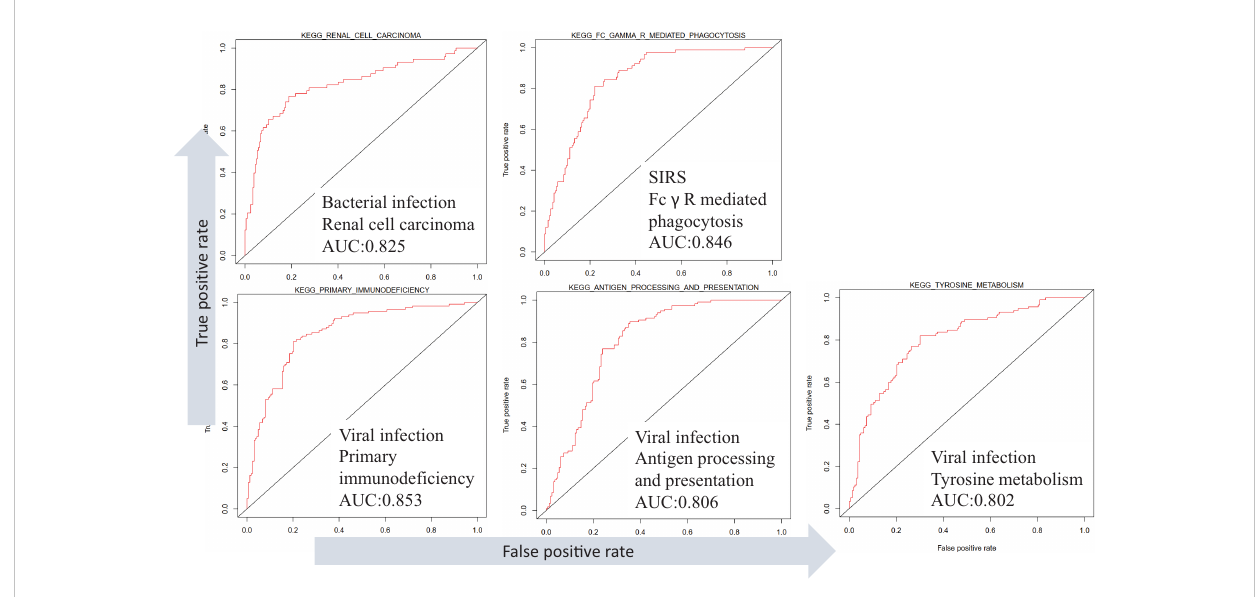
FIGURE 7 Differentiation of SIRS, bacterial and viral sepsis using KEGG pathway expression based on dataset GSE63990.